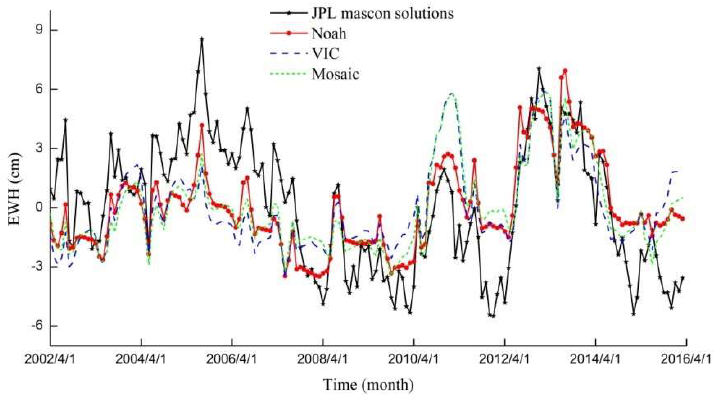
Figure 7. Comparison between the JPL mascon-based TWSA and SMS of different hydrological models over the Liao River Basin from April 2002 to March